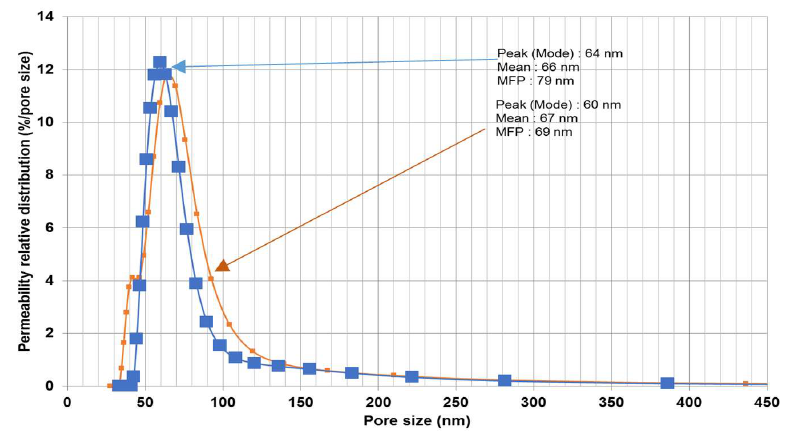
Figure 10. Pore size distribution of fabricated membrane.